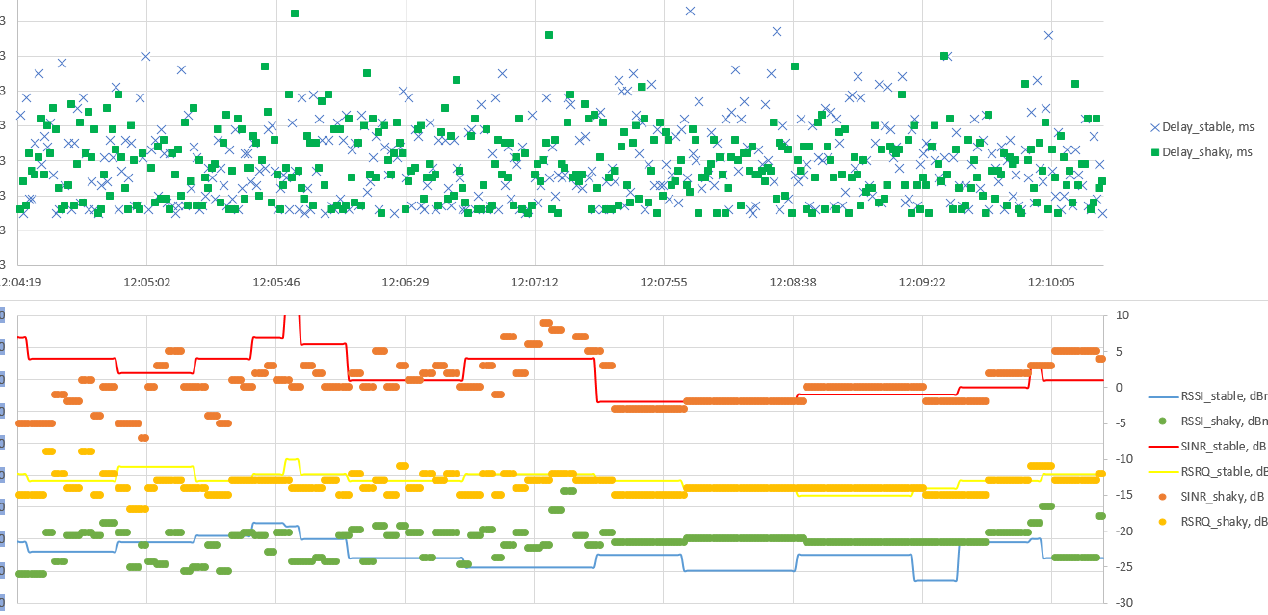
Fig. 8. Network performance for the movable UE with fixed and with jiggled antennas in LTE